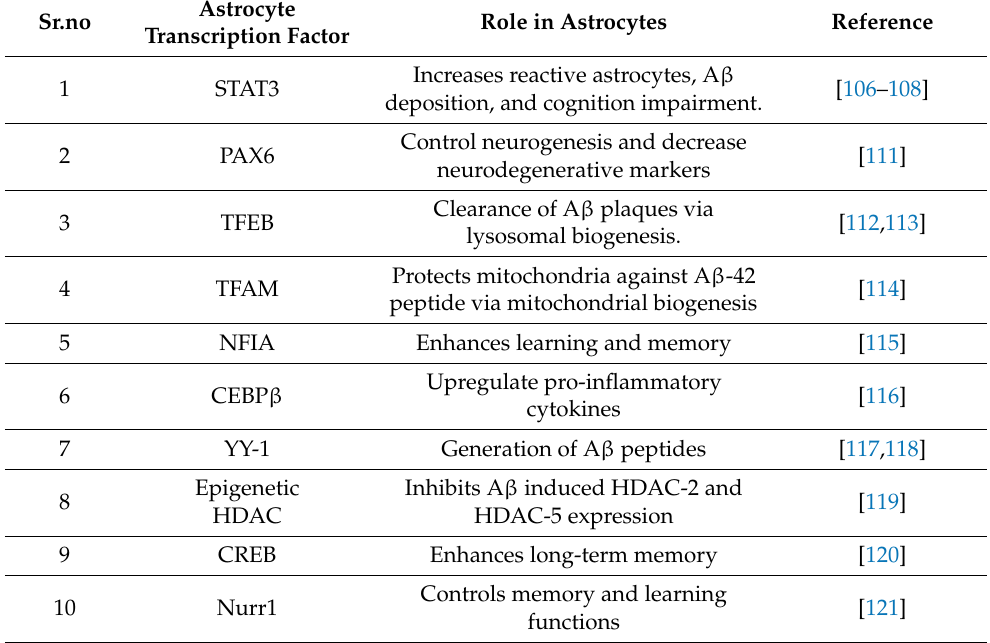
Table 1. Astrocyte-specific transcription factors in